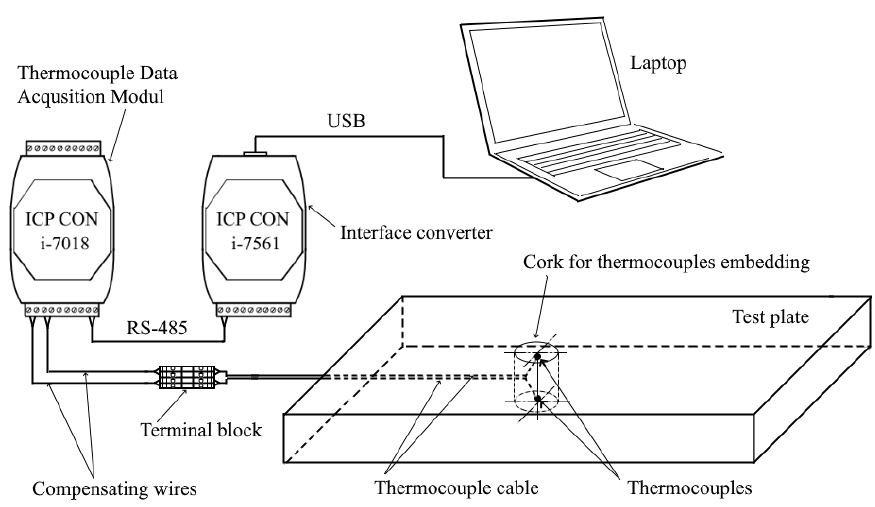
Figure 11. Schematic of the measuring complex.